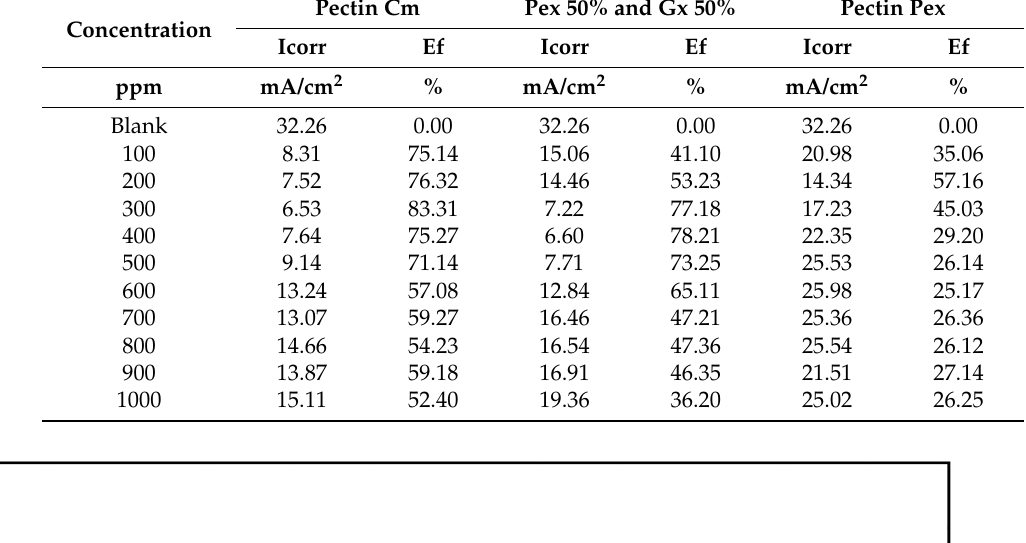
Table 2. Corrosion inhibitor efficiency: commercial pectin (Cm), extracted pectin (Pex), and the 50%:50% formulation of Pex and Gx.